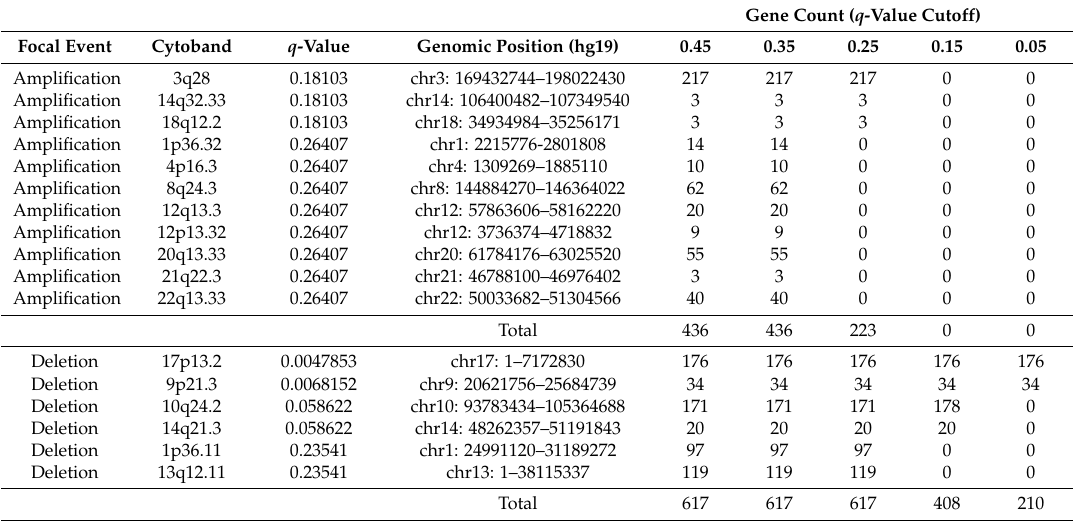
Table 6. List of regions and their associated genes located in the most common sections of recurrent DNA CNAs, derived from analysis conducted on malignant astrocytic brain tumor samples. Benign cases were excluded.